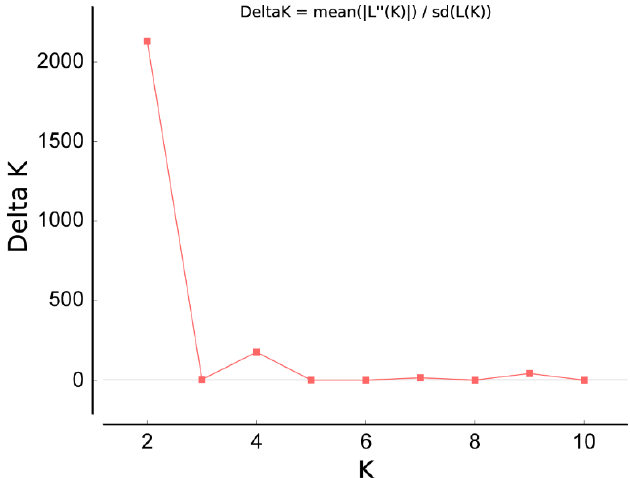
Figure 4. The best suitable K-means obtained by the ΔK method in STRUCTURE Harvester. The range of 1 to 11 possible clusters with three independent runs were obtained at 100,000 simulations after a burn-in of 100,000 simulations. Diversity 2020 , 12 , x FOR PEER REVIEW